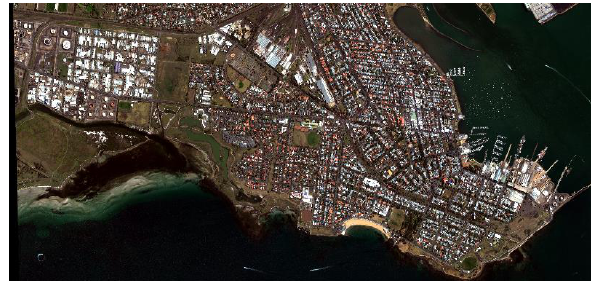
Figure 4. Orthorectified satellite image.